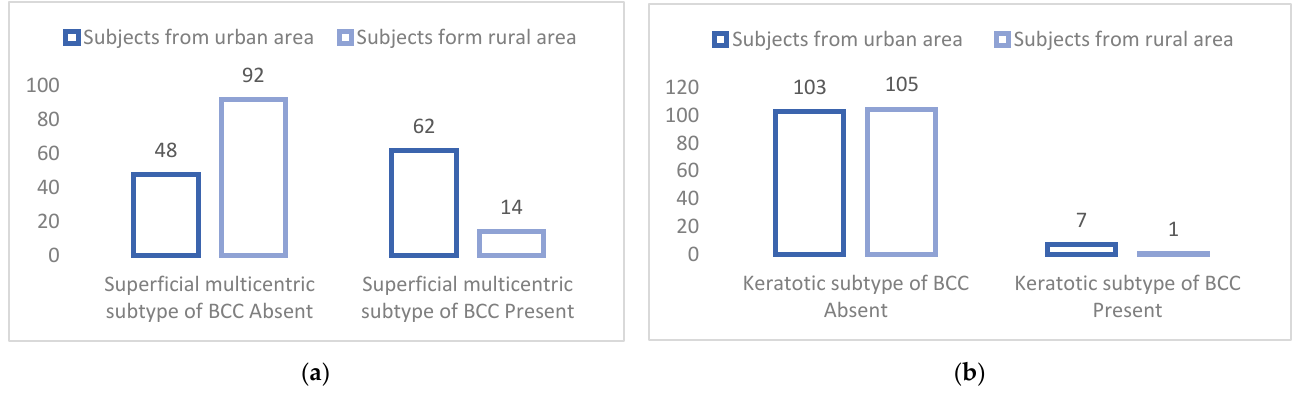
Figure 2. ( a ) Significant differences between urban and rural subjects in terms of the incidence of diagnosis with superficial multicentric BCC subtype. ( b ) Significant differences between urban and rural subjects in the incidence of diagnosis with keratotic BCC subtype.